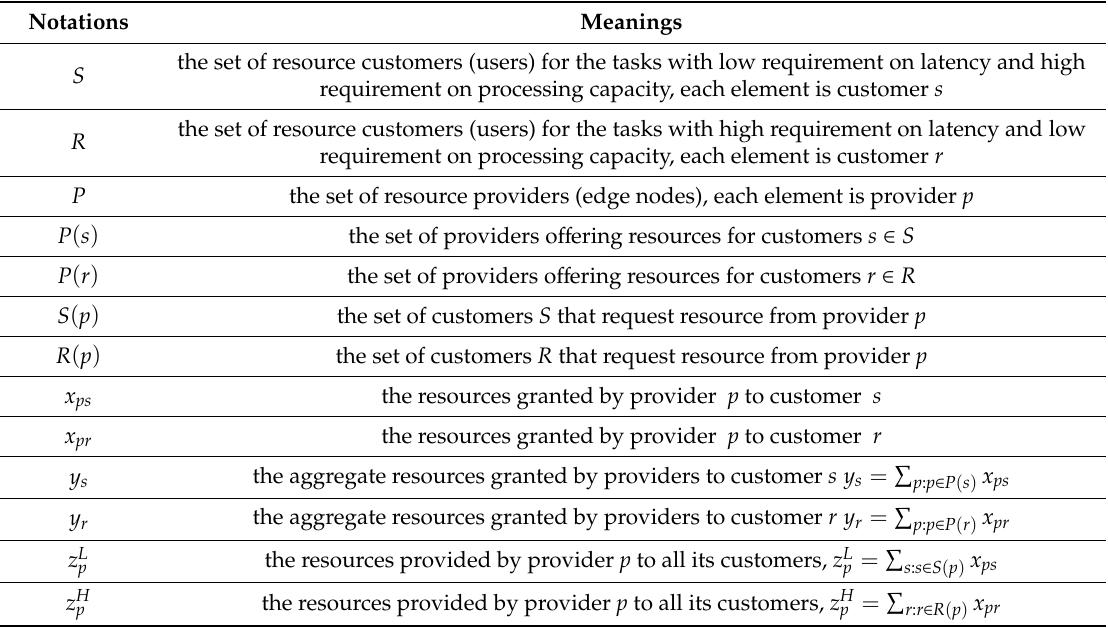
Table 1. Notation